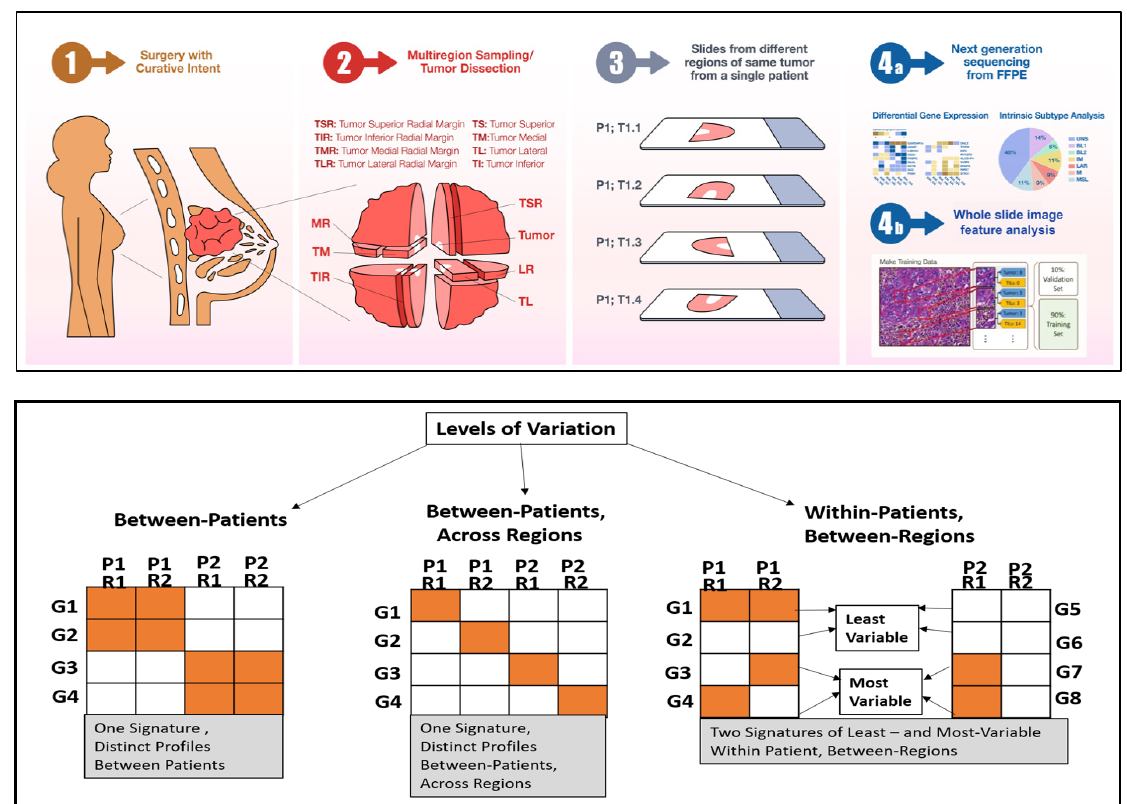
Figure 1. Overview of study design and analyses. ( Top ): Schematic representation of specimen selection, multiregional sampling, data generation, and processing steps. ( Bottom ): Schematic of three levels of variation: between-patients, between-patients across regions, and within-patients between regions. For the first two levels, a single gene signature is defined (based on four genes in this schematic) with distinct expression profiles (orange, expressed; white, not expressed) between patients or between patients and across regions. In the third variation level, 2-gene signatures are defined for each patient; one with high and one with low variation between regions. In this example, the least variable gene signature could be characterized by either expressed genes or genes with low to no expression